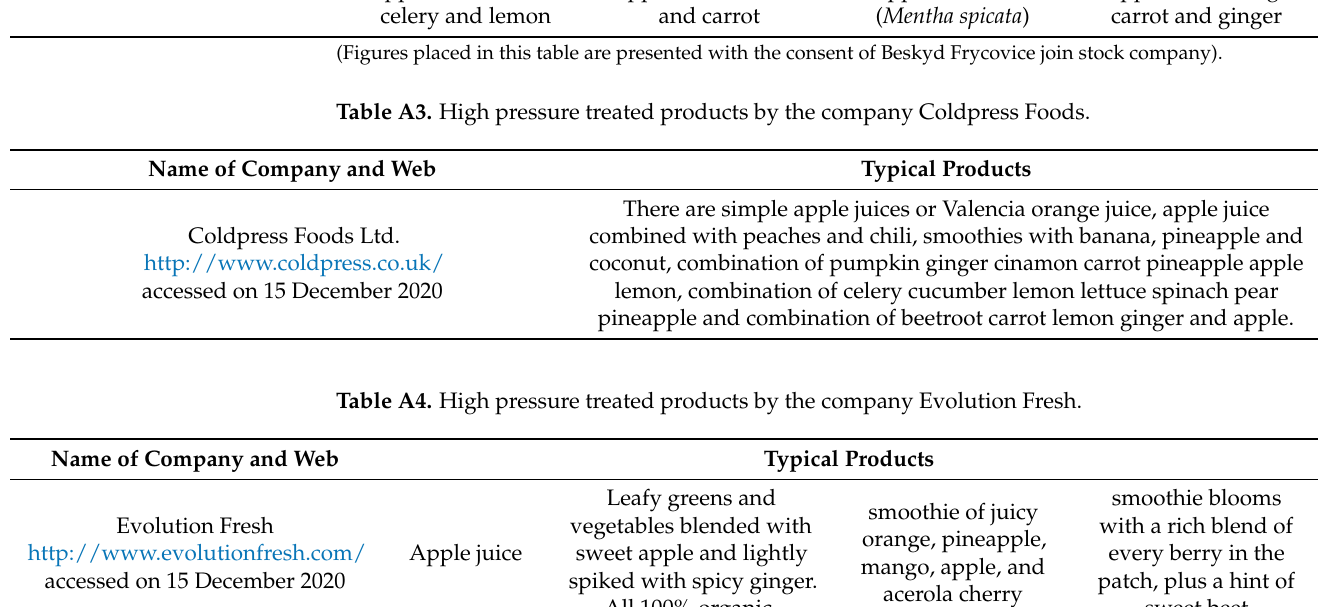
Table A5. High pressure treated products by the company Fruity Line.